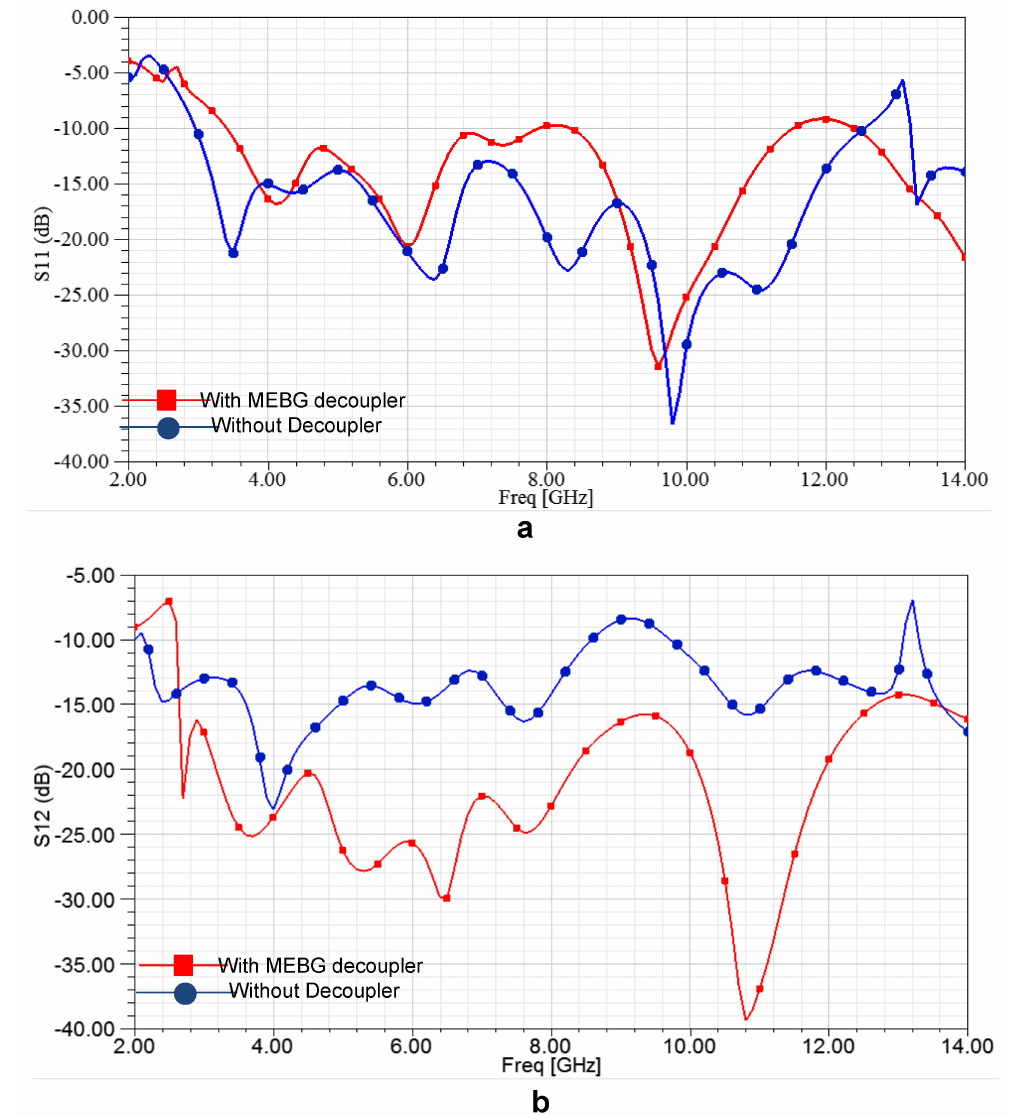
Figure 10. MIMO − UWB antenna S − parameter ( a ) S 11 , ( b ) S 12